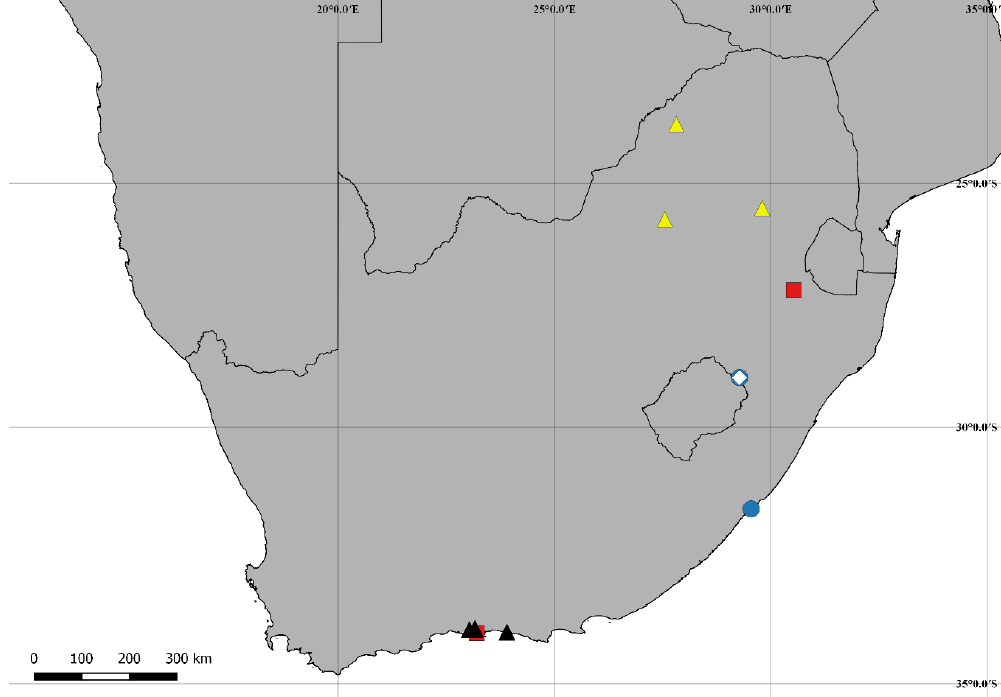
Figure 15. First records of Cis fuscipes Melli é (red square), corrected distributional records of Cis masekelai Souza-Gonçalves & Lopes-Andrade (yellow triangle) and new distributional records of Cis neserorum Souza-Gonçalves & Lopes-Andrade (blue circle), Cis regius Orsetti & Lopes-Andrade (black triangle) and Cis stalsi Souza-Gonçalves & Lopes-Andrade (white diamond) from southern